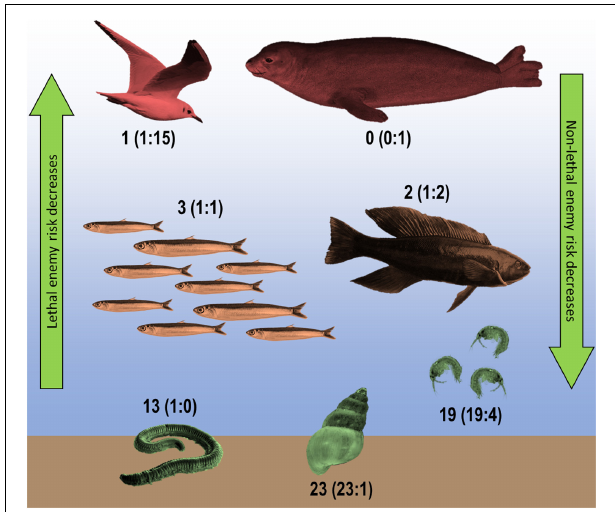
FIGURE 2 | Number of lethal natural enemy species (i.e., enemies that effectively eliminate the fitness of victims, such as predators and parasitic castrators) with the ratio of lethal to non-lethal natural enemy species (i.e., enemies that reduce fitness to between 0 and 1, such as trophically transmitted parasites and pathogens) in parentheses for different organismal animal groups (body size is not to scale) in a simplified food web of a tidal basin that approximates trophic level. From left to right, primary consumers in green include annelids, snails, and amphipods; secondary consumers in orange include schooling fishes and solitary fishes; tertiary consumers in red include birds and mammals. The numbers for each animal group are median values calculated for a number of species that were included in each group ( Supplementary Material ). Note that, for mammals, only one species was available from the